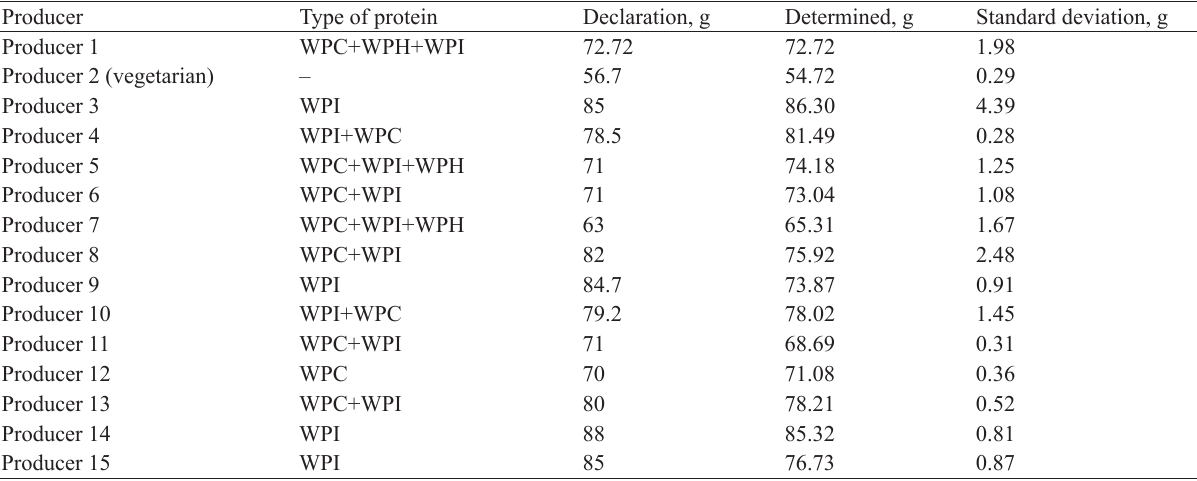
Table 1 Protein content in whey protein samples measured by the Kjeldahl method